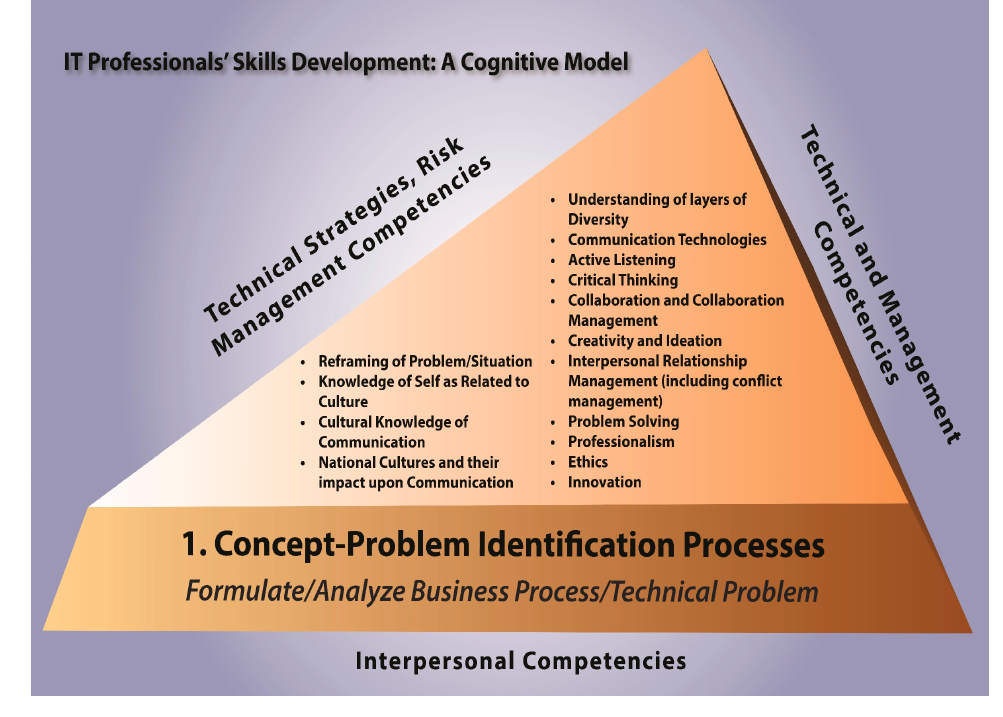
Figure 2. Illustration of the Necessary Non-technical Skills for Step 1: Problem Identification Process within a simulated IT Project Systems Development Life Cycle Context.